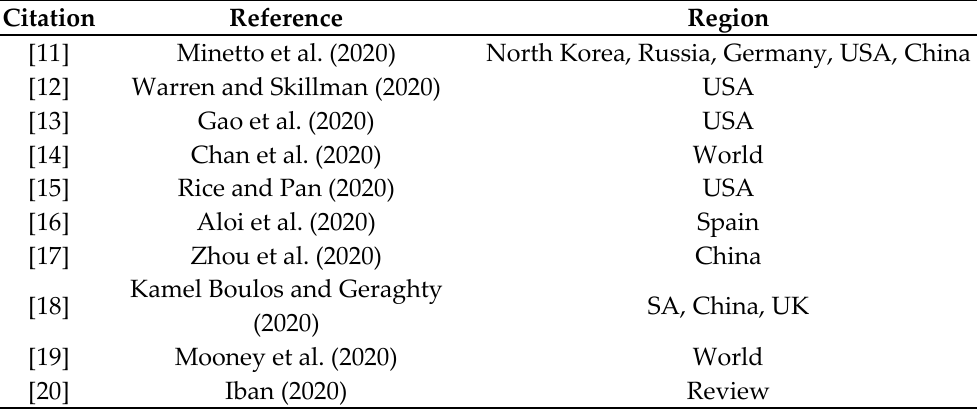
Table 1. Literature